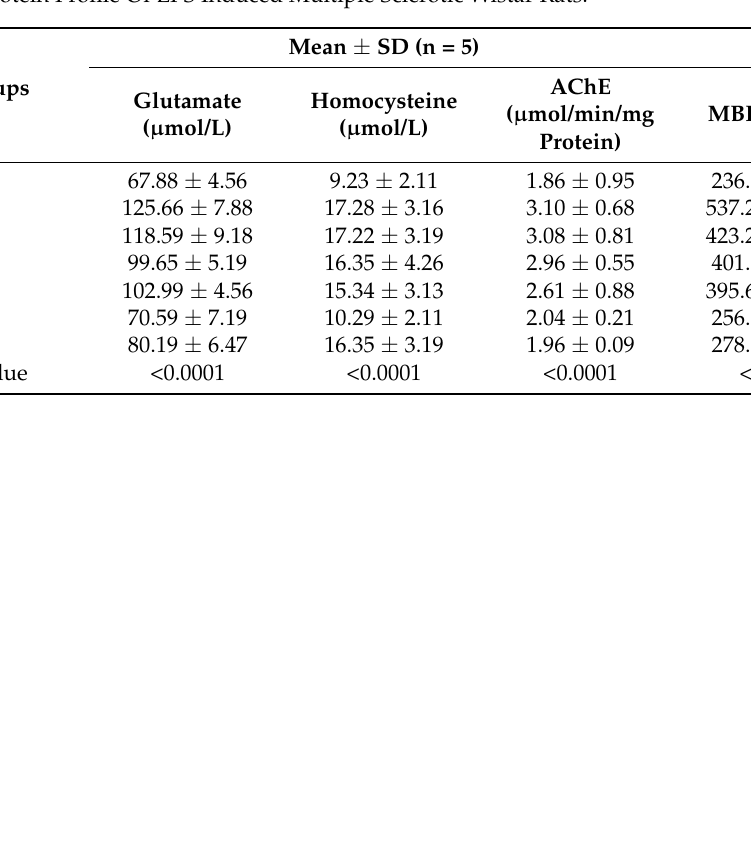
Table 6. Protein Profile Of LPS Induced Multiple Sclerotic Wistar